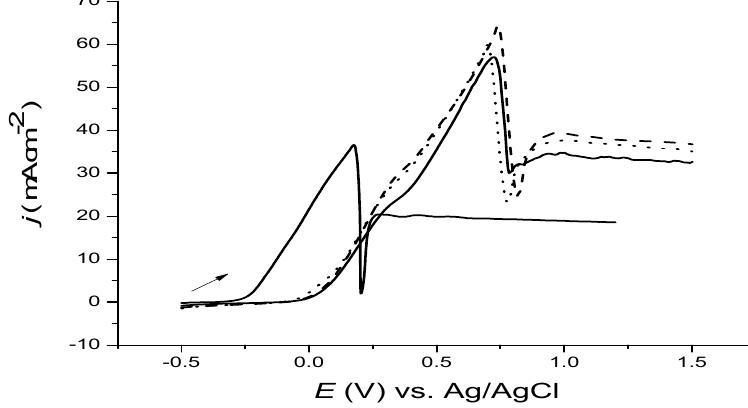
Figure 2. Linear sweep voltammetry (LSVs) of copper discs in choline chloride-based IL (ChCl:EG 1:2, solid line), and the other three shifted, LSV-overlapped responses of copper discs in 1-butyl-3-methylimidazolium chloride (C4mimCl):EG with ratios of 1:2, 1:3, and 1:4, represented by dashes, dots, and solid lines, respectively, at 5 mV·s − 1 and 20 °C.